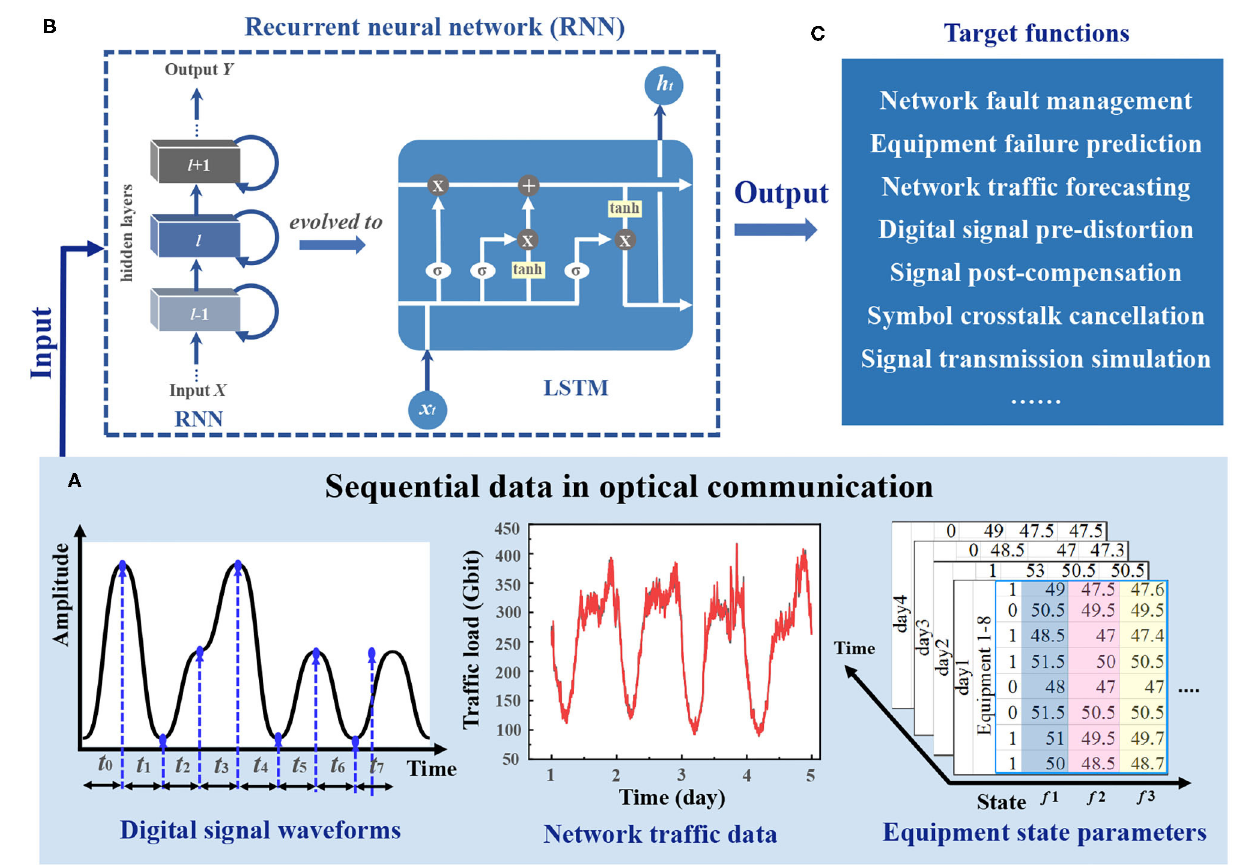
FIGURE 3 | Application of recurrent neural network (RNN) in optical communication for sequential data processing. (A) Summarization of sequential data in optical communication: digital signal waveforms, network traffic data, and equipment state operating parameters. (B) The schematic of RNN considers the extracted features in the previous state as the one of the current input information and the current outputs depend on the current and previous inputs to provide the neural network with memory; and Long short-term memory (LSTM) block diagram is the variant of RNN that can learn long-range temporal relationships among sequential data. (C) A variety of functions can be achieved by RNN for optical